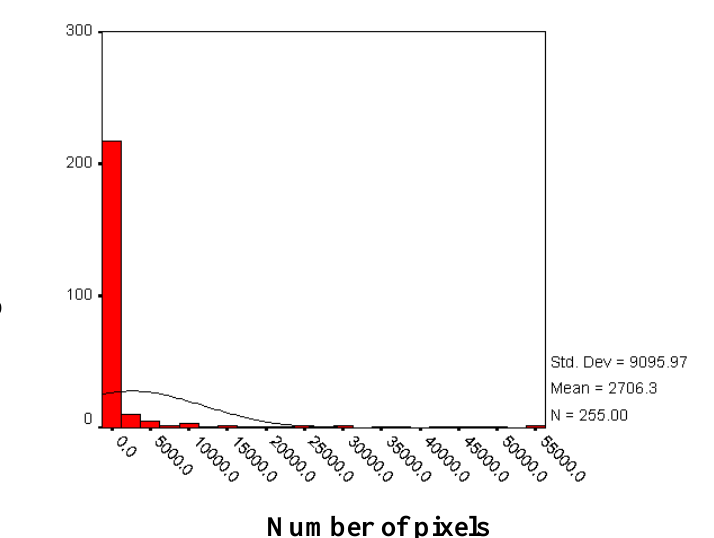
Figure 3. Distribution of the boresight